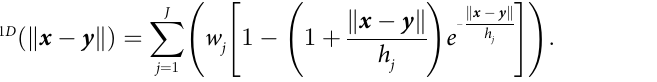
Epidemics were simulated using BWME kernels with parameters s 1 and s 2 (left), approximating exponential mixture kernels with J mixture components (right).